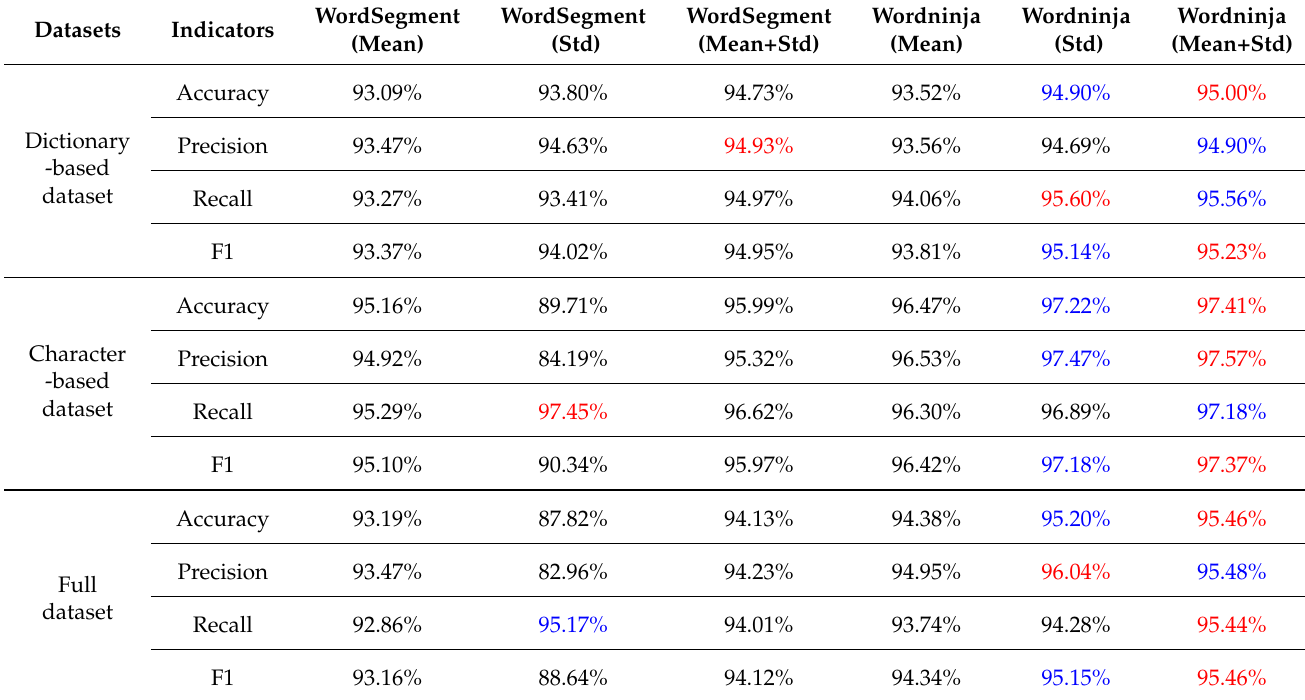
Table 7. Performance of different word distribution